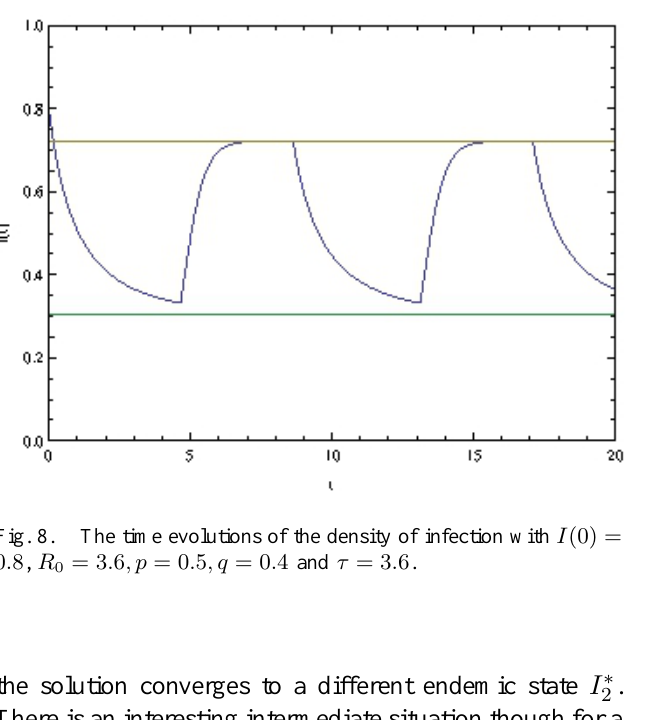
Fig. 8. The time evolutions of the density of infection with I (0) = 0 . 8 , R 0 = 3 . 6 , p = 0 . 5 , q = 0 . 4 and τ = 3 . 6